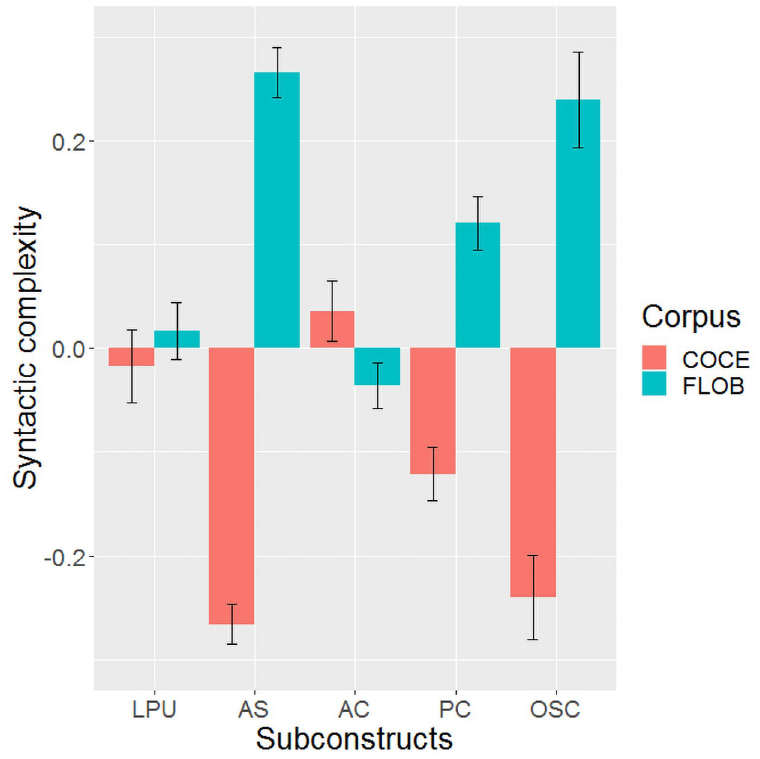
Fig 3. Comparison of the two corpora in syntactic complexity for each measure. Error bar represents ± SE. LPU = Length of Production Unit, AS = Amount of Subordination, AC = Amount of Coordination, PC = Phrasal Complexity, OSC = Overall Sentence Complexity.